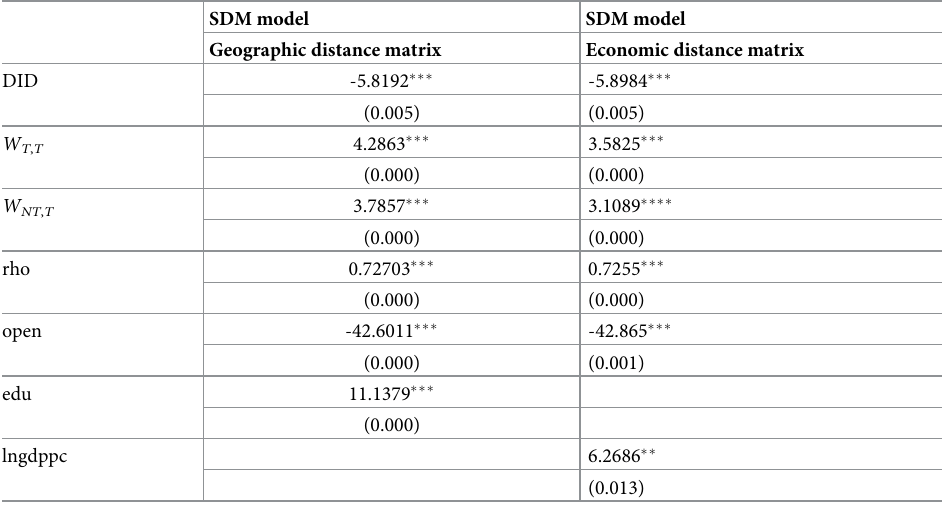
Table 5. Spatial DID regression